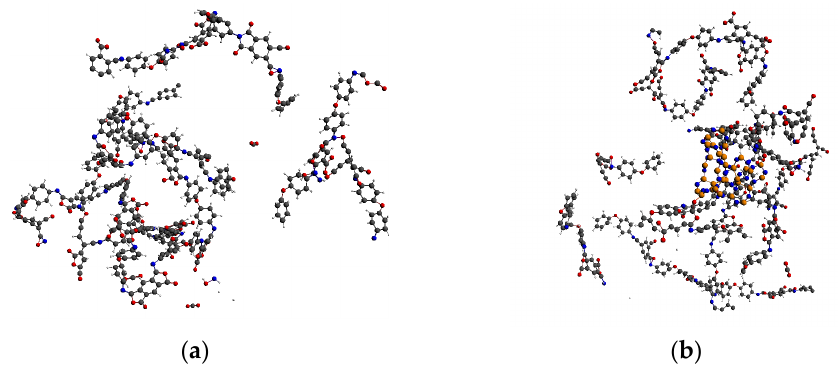
Figure 3. Pyrolysis results at 2000 K. ( a ) PI neat; ( b ) PI/BNNS.